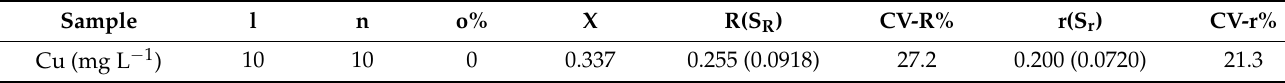
Table 6. Summary of interlaboratory test results from the Lemna toxicity